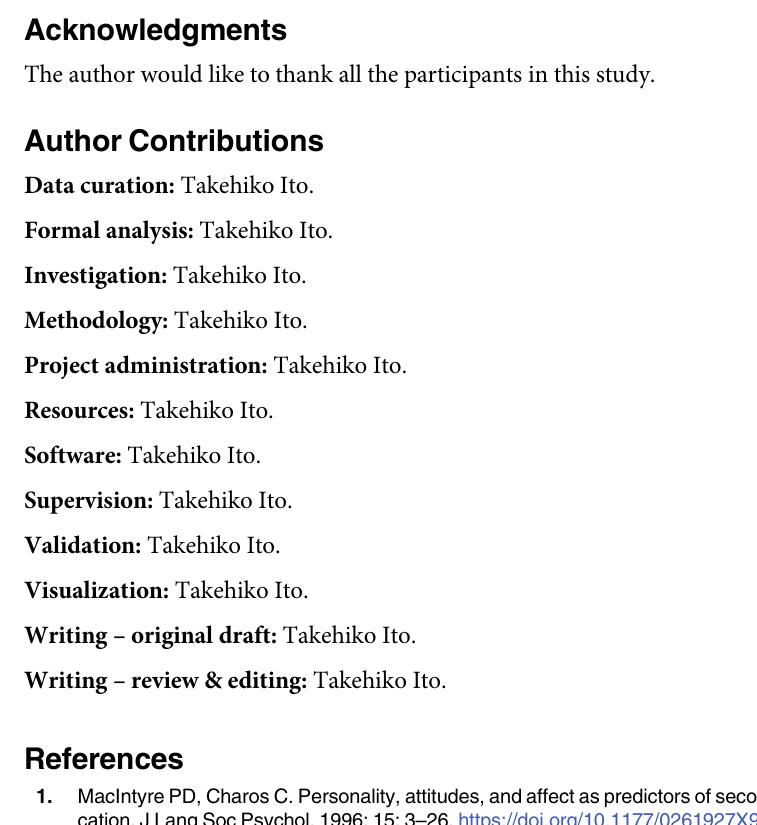
S1 Fig. Network structure of psychological factors and the WTC in English after control- ling for age and sex. S2 Fig. Centrality indices are shown as standardized z-scores after controlling for age and